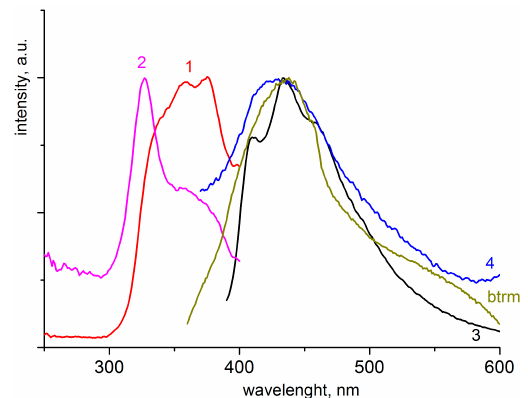
Figure 7. Normalized emission ( λ ex = 330 nm and 375 nm) and excitation spectra: 1, 3—compound 1 ; 2, 4—compound 2 . Normalized emission ( λ ex = 330 nm) spectrum of btrm. Table 1. Photoluminescence data for coordination polymers 1 , 2 and ligands btrm, btrp.